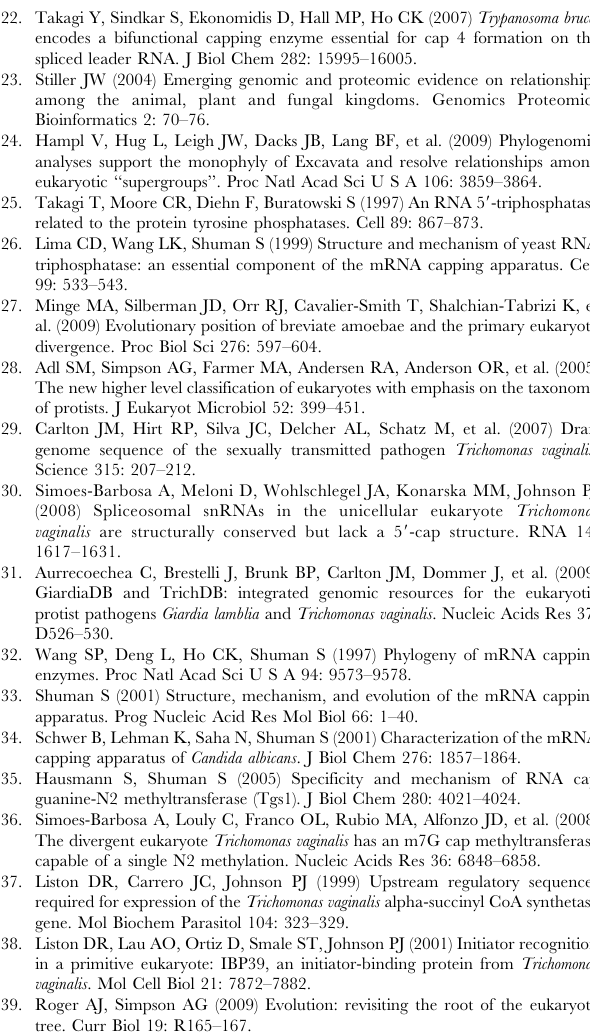
shown. The alpha shape parameter was optimized first and fixed for the bootstrap analyses with NNI and TBR branch swapping for further optimizations. Scale bars represent the inferred number of changes per site. Table S1 Full names of species used in phylogenetic analyses and accession numbers for all gene sequences used in the work described